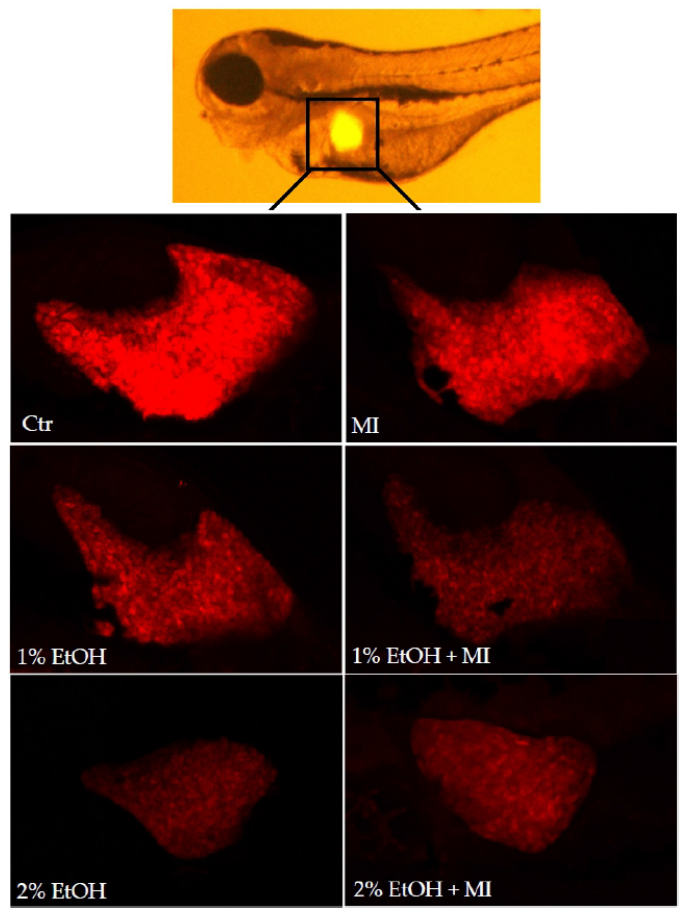
Figure 6. Confocal microscopy images of zebrafish larvae liver.